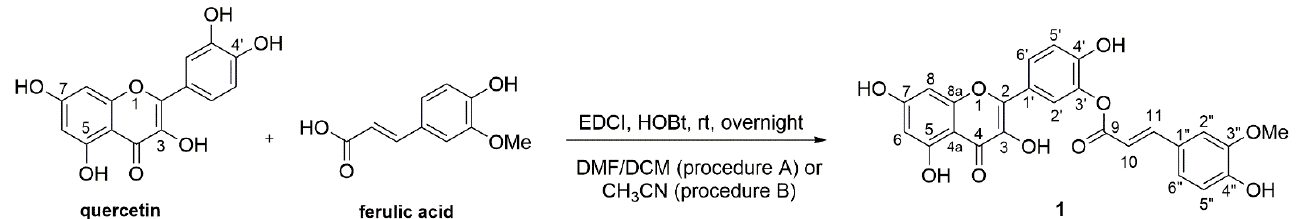
Table 1. 1 H- and 13 C-NMR (600 MHz, DMSO- d 6 ) chemical shifts of the protons and carbons of quercetin (Que) and 3 (cid:48) -ferulic quercetin ester (Compd. 1